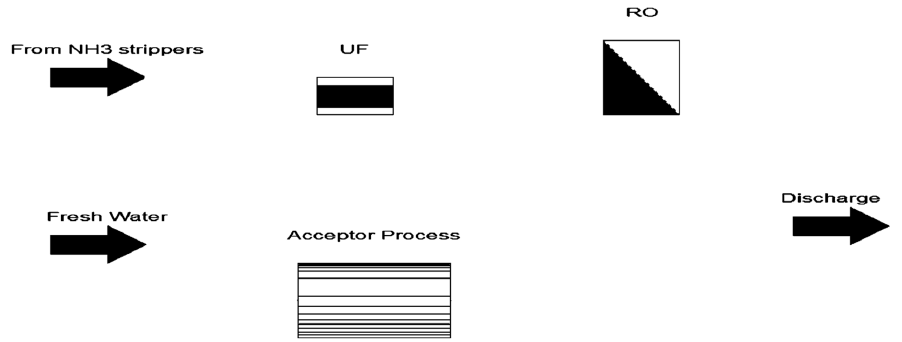
Figure 4. Water-Int model before simulation: unconnected blocks.